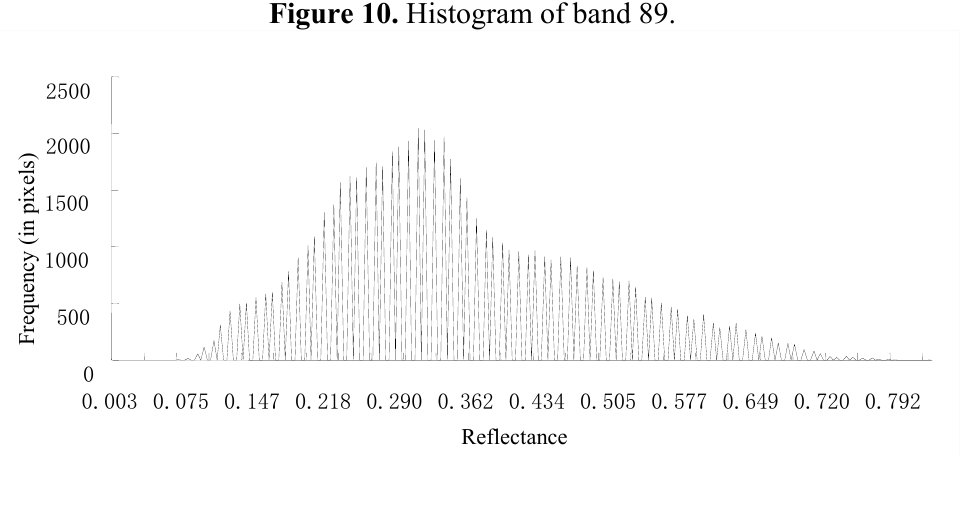
Figure 10. Histogram of band